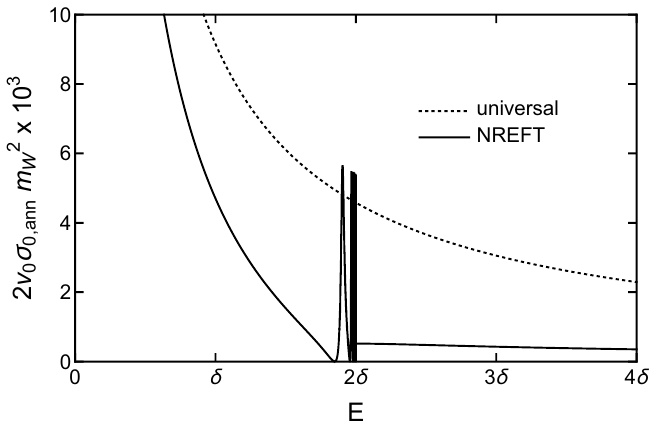
Figure 13 . Neutral-wino-pair annihilation rate at the unitarity mass M (cid:3) = 2 : 39 TeV as a function of the energy E : NREFT (solid curve) and the universal approximation in eq. (3.20b) (dashed curve).